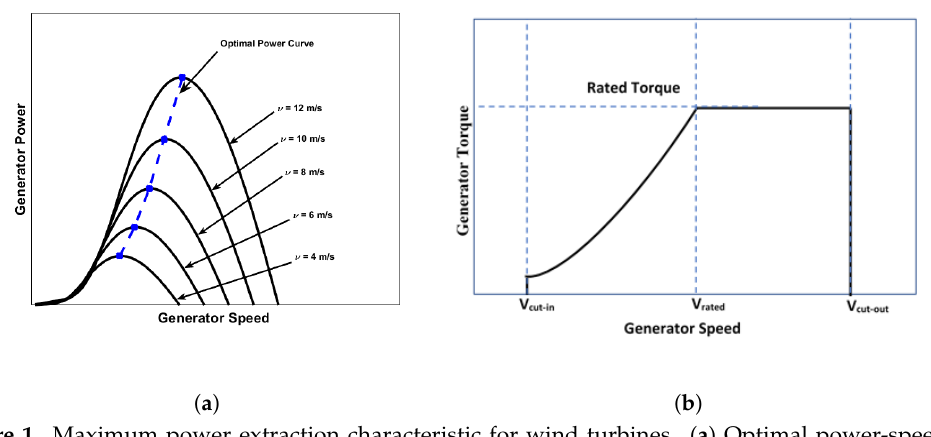
Figure 1. Maximum power extraction characteristic for wind turbines. ( a ) Optimal power-speed characteristics ( b ) Torque-speed